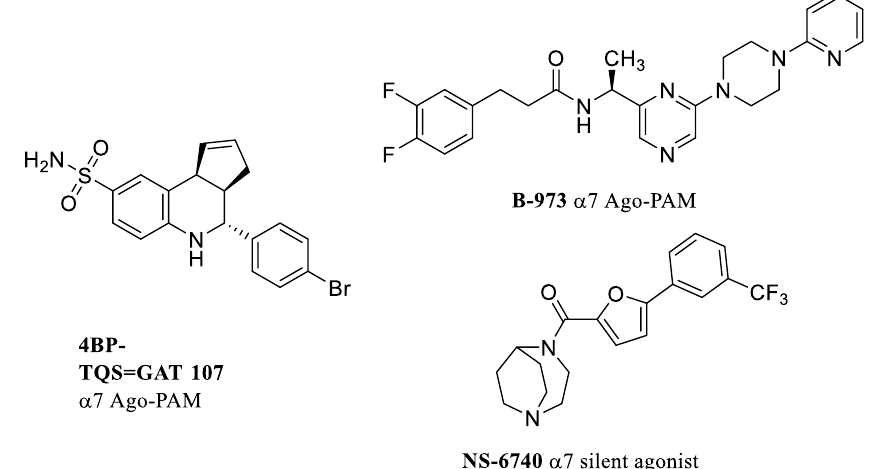
Figure 2. Examples of allosteric activating PAMs (Ago-PAM) and silent